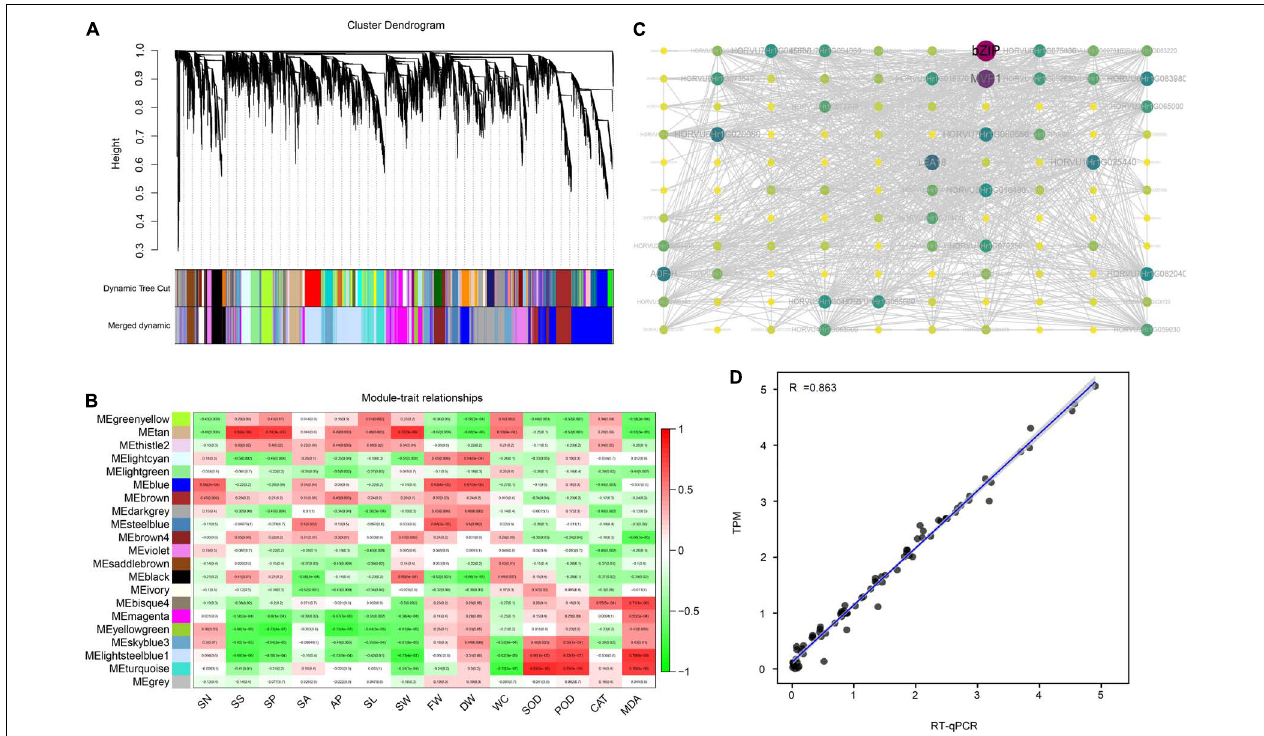
FIGURE 5 | Results of Weight Gene Coexpression Network Analysis (WGCNA). (A) The clustering dendrogram of genes with dissimilarity based on topological overlap computed by WGCNA. The original modules and merged modules are colored below the clustering dendrogram; (B) the relationship between modules and traits; (C) the network within the Tan module. The degree value was mapped as node color and size. More modules are shown in Supplementary Figure 8 . (D) The relationship between the transcriptome data and RT-qPCR. TPM: Transcripts per million, used to represent the expression